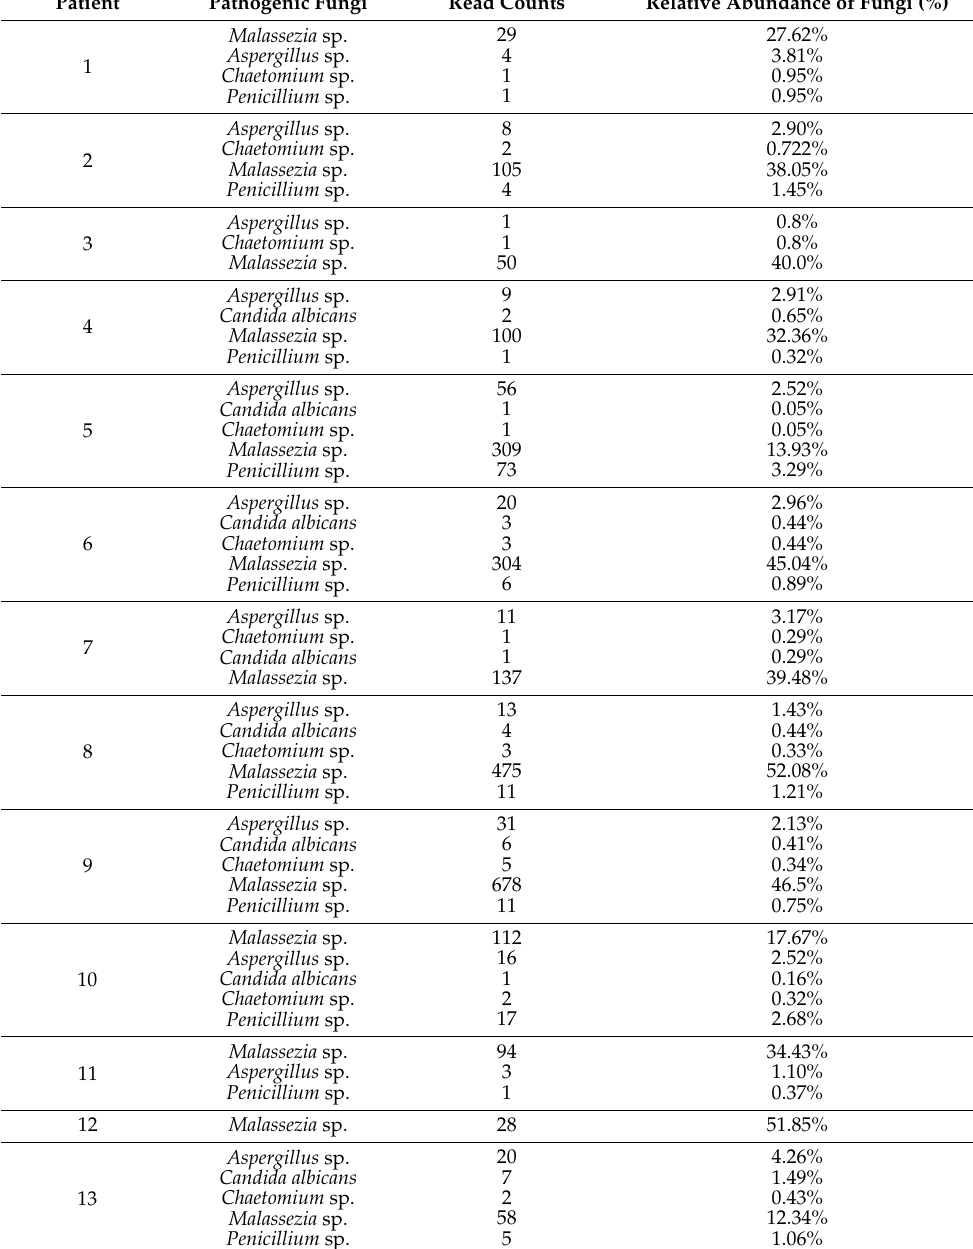
Table 5. The pathogenic fungi identified by nanopore